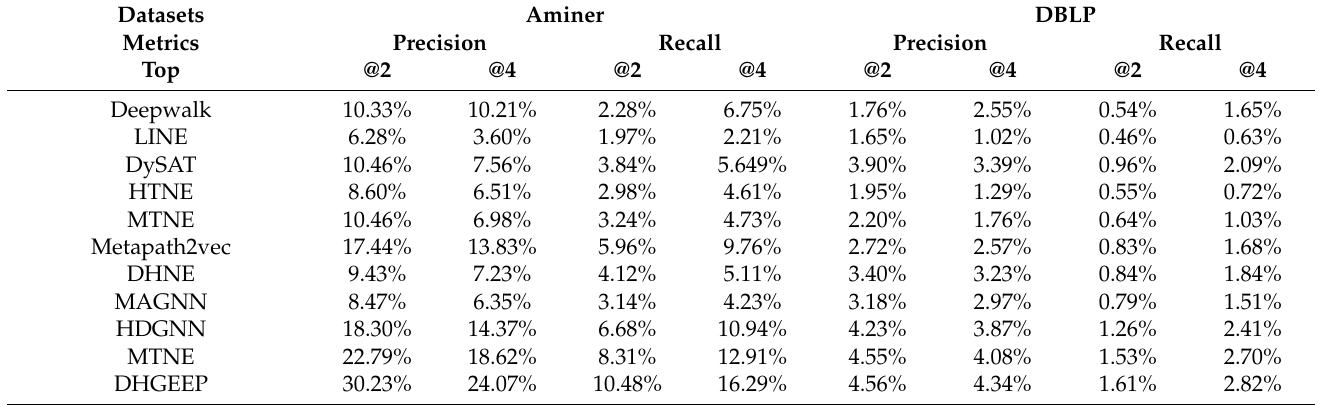
Table 4. Comparison of different algorithms in heterogeneous temporal event